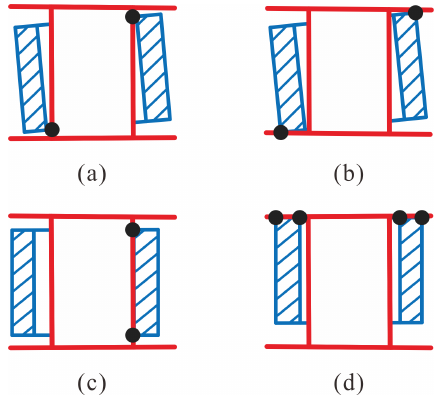
Figure 2. Contact states, including (a) point contact I, (b) point contact II, (c) line contact, and (d) surface